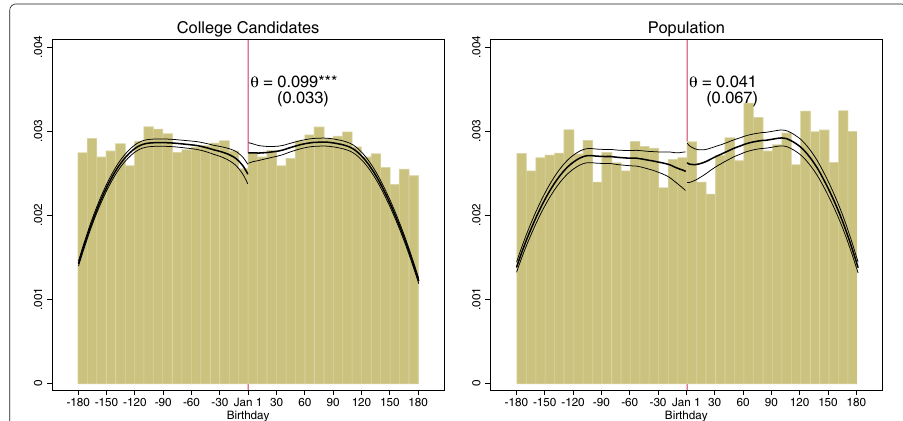
Fig. 1 Distribution of birthdays and the McCrary density test. This figure shows the histograms of birthdays with the bin width equal to 10 days. The center of the graphs is zero, which represents January 1. The first graph on the left is the distribution of birthdays of UFPE first-time candidates between 2002 and 2005. The second graph on the right (PNAD data) is the distribution of birthdays of children born between July 1984 and June 1988, living in the state of Pernambuco, and with similar parental education to that of the UFPE candidates. θ is McCrary’s (2008) estimator for log density discontinuity, with standard errors in parentheses . *** represent statistical significance at the 1 % level